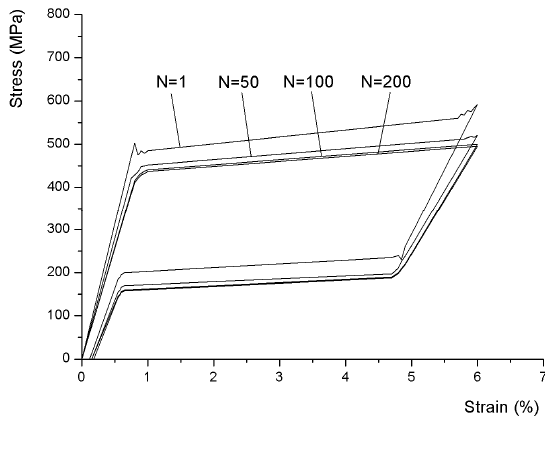
Figure 7 . The schematic illustration for the influence of cyclic effect to NiTi